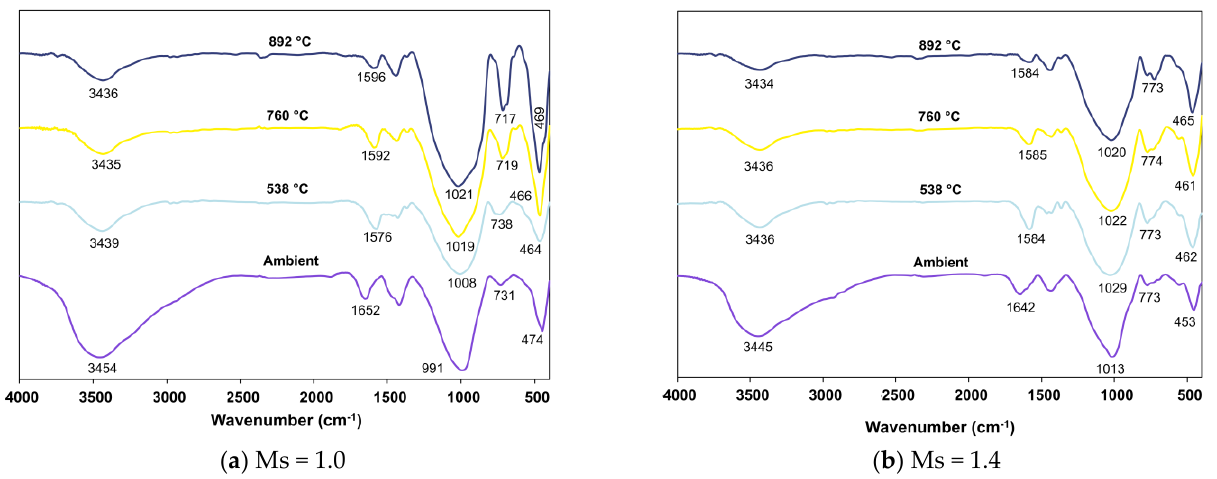
Figure 11. FTIR spectra of FS 30P on exposure to elevated temperature.